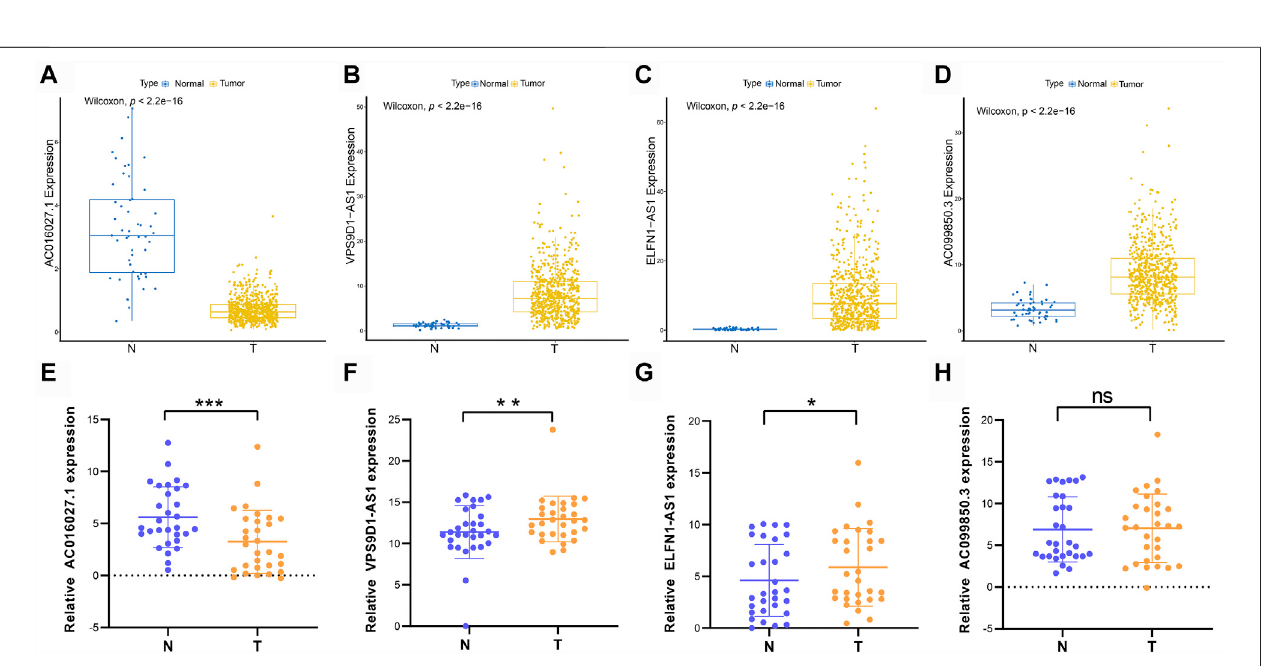
FIGURE 9 | Functional annotation of mRNA. (A) GO items enriched by GSEA analysis on the network-genes. (B) KEGG pathways enriched by GSEA analysis on the network-genes.